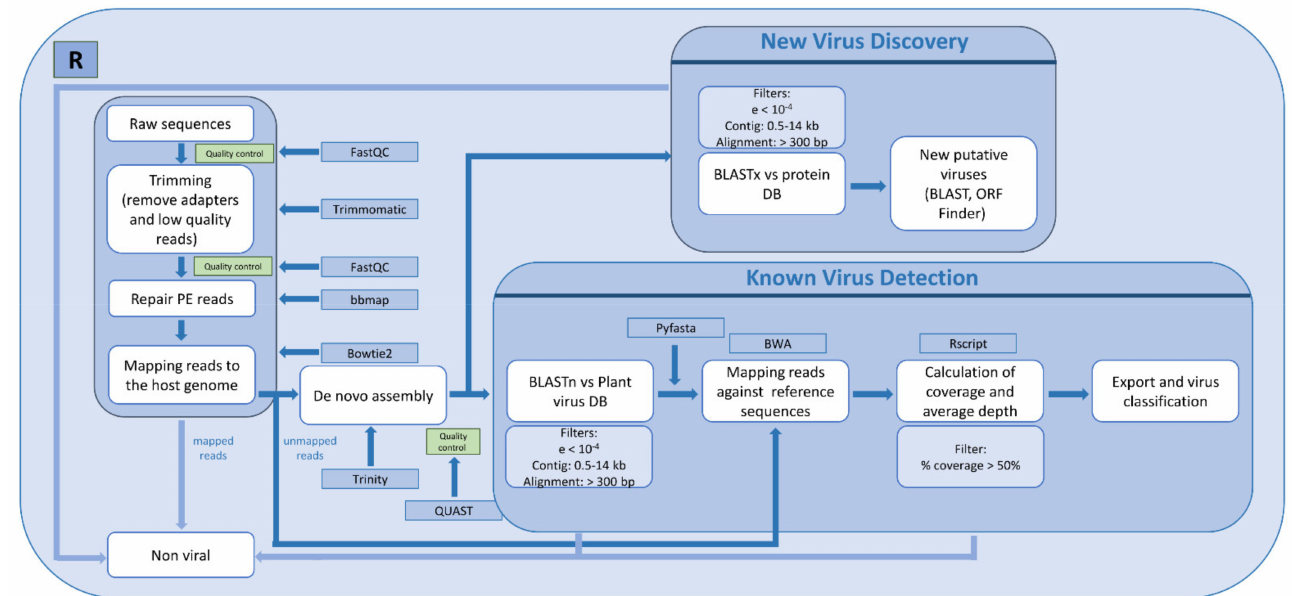
Figure 1. Bioinformatic workflow for the detection of known viruses and for novel virus discovery. Schematic representation of the bioinformatics pipeline followed in this work implemented in the R language. Specific programs (blue rectangles) used for each step (white rectangles) are indicated; applied filters are framed in light blue